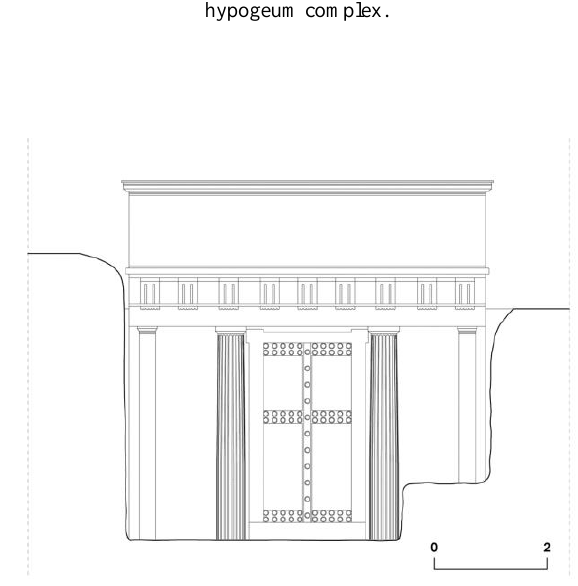
Figure 17. The Great Mound at Verghina. General plan of the hypogeum complex.